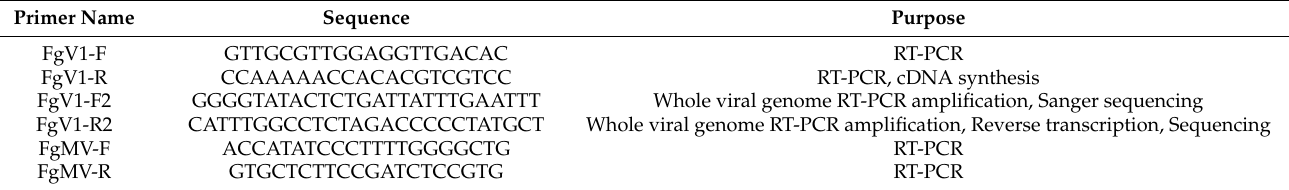
Table 1. List of primers used in this chapter.